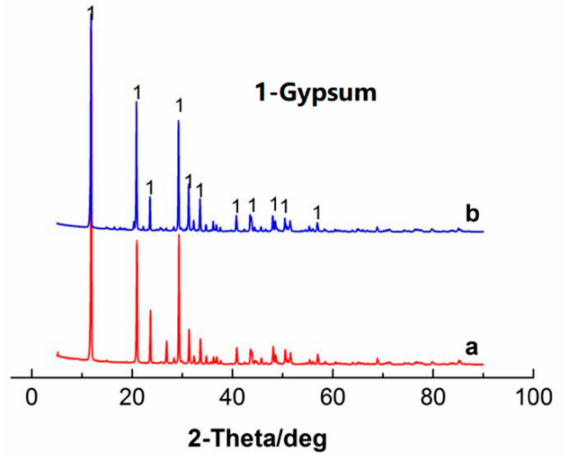
Figure 13. XRD pattern of the residue after sulfuric acid leaching. ( a ) Conventional: mass fraction of sulfuric acid = 15%, particle size = − 150 µ m, solid–liquid ratio = 1:7, temperature = 25 ◦ C, stirring speed = 150 rpm, leaching time = 80 min; ( b ) ultrasonic: power = 600 W, mass fraction of sulfuric acid = 15%, particle size = − 150 µ m, solid–liquid ratio = 1:7, temperature = 25 ◦ C, leaching time = 40 min. Table 2. The main components of the leached residue after conventional and ultrasonic leaching.